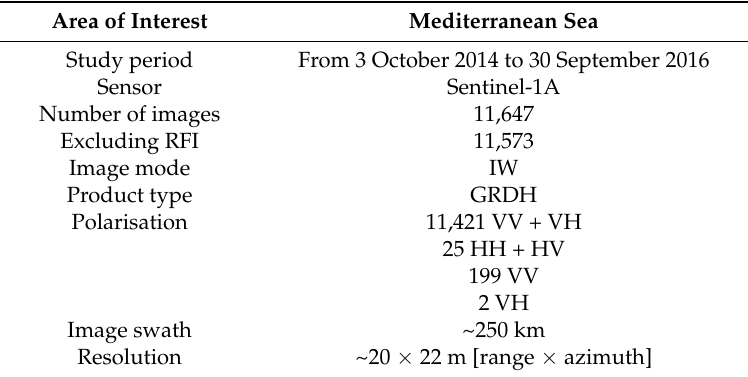
Table 1. Main details of the satellite SAR images used in this